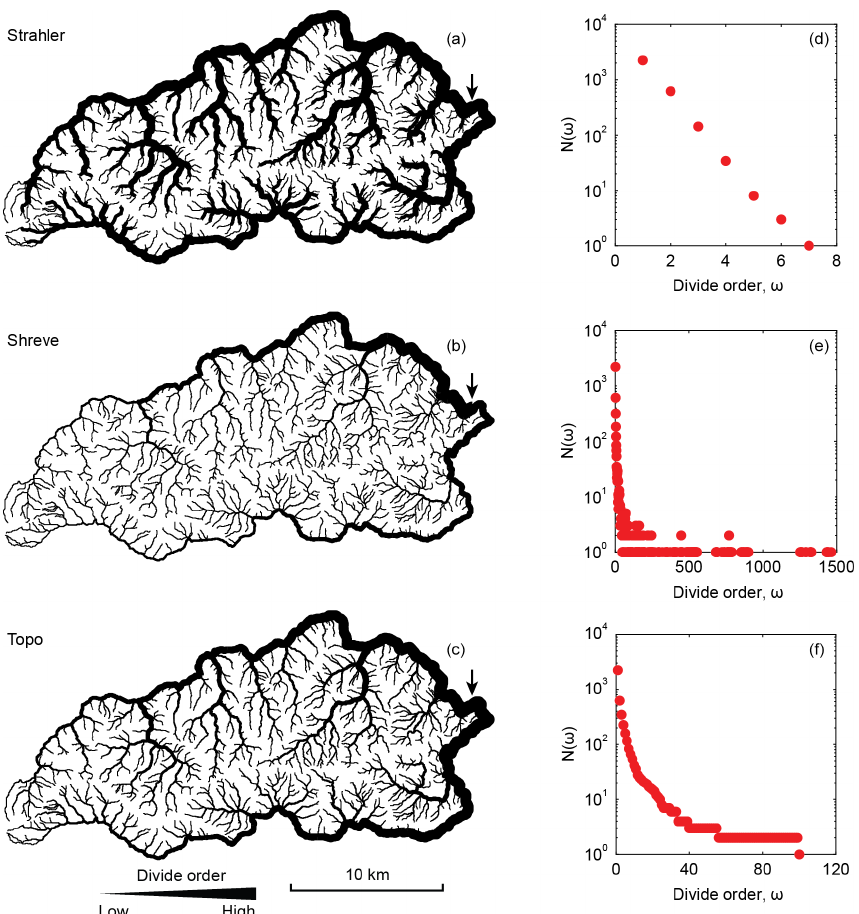
Figure 7. Divide network of the Big Tujunga catchment in the western San Gabriel Mountains, California, USA. Panels (a) – (c) show the divide network, with line thickness indicating the divide order. Arrow marks the last divide segment encountered in the sorting process or, equivalently, the root of the tree-like network. Panels (d) – (f) show the number of divide segments as a function of divide order.